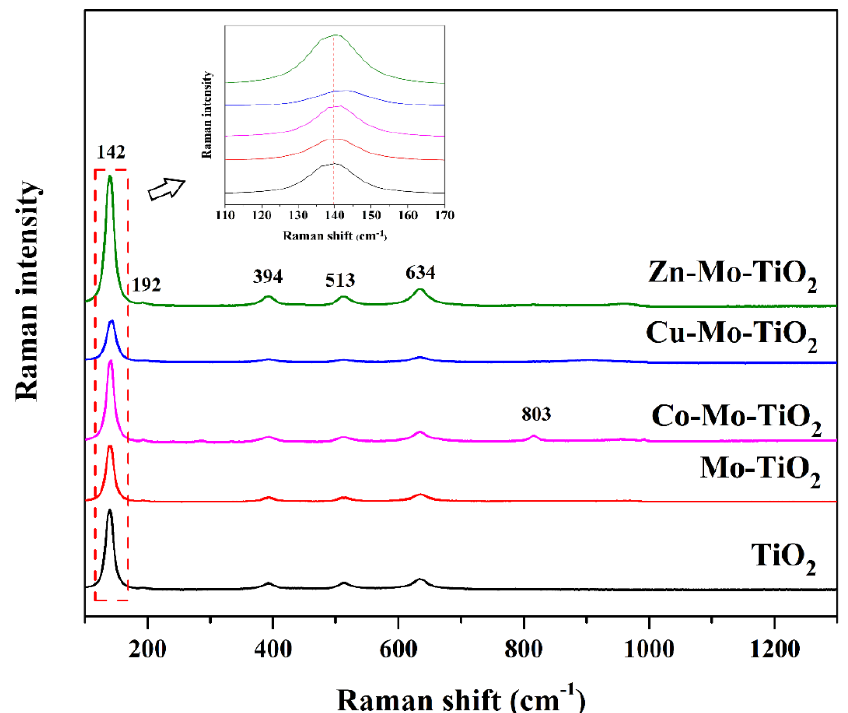
Figure 4. Raman spectra of TiO 2 , Mo − TiO 2 , Co − Mo − TiO 2 , Cu − Mo − TiO 2 , and Zn − Mo − TiO 2 .